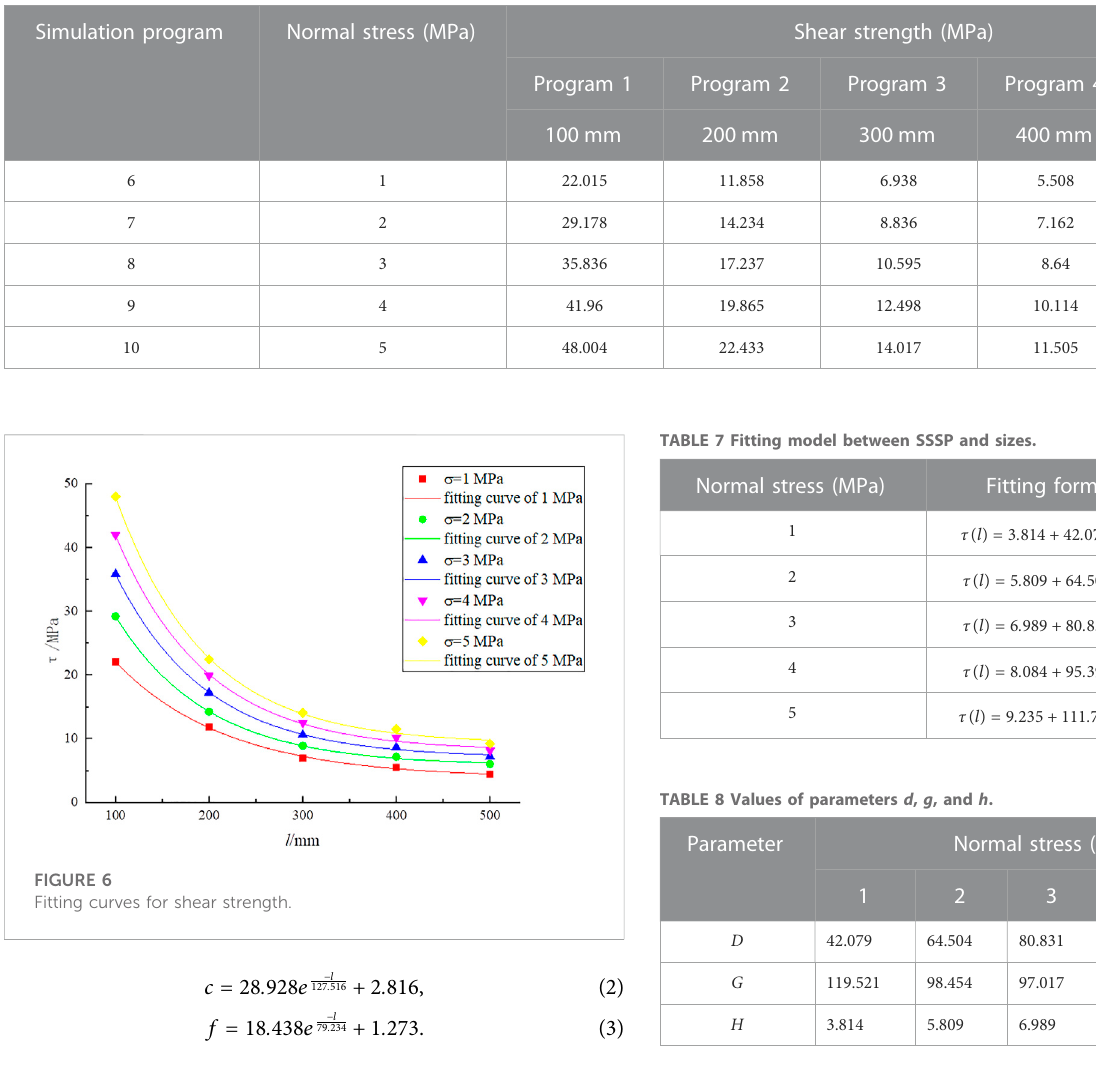
Figure 5A through Figure 5E demonstrate the similar curve laws.